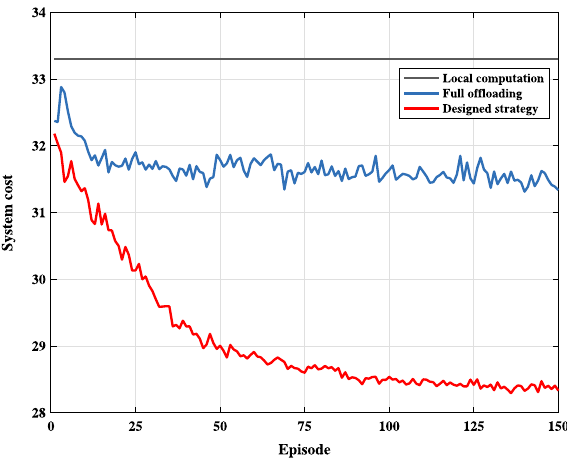
Fig. 4 The convergence of the designed strategy versus